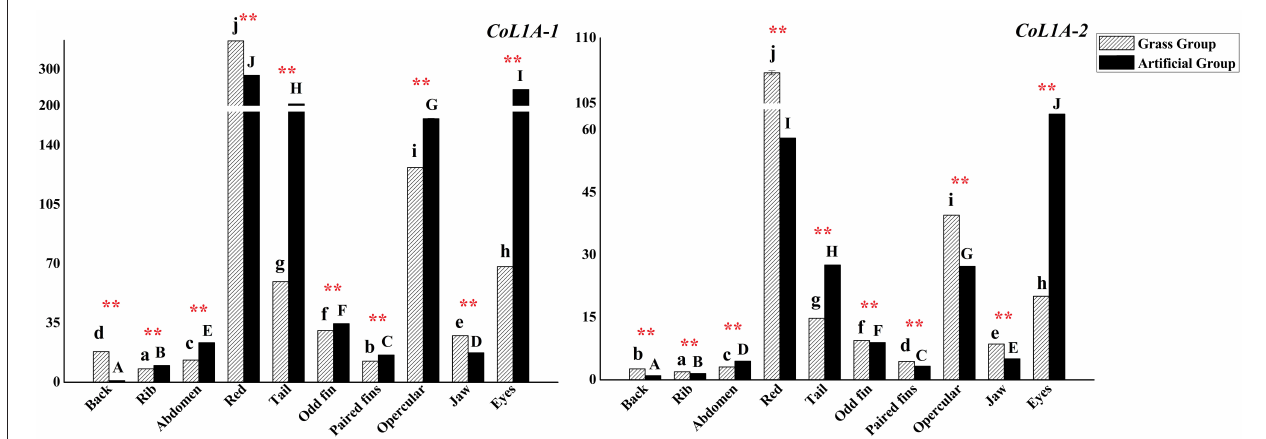
FIGURE 7 | The expression levels of C. idellus CoL1A - 1 and CoL1A - 2 in different muscle tissues . The expression levels of C. idellus CoL1A - 1 and CoL1A - 2 in back, rib, abdomen, red, tail, odd fin, paired fins, opercular, jaw, and eyes positions of the two culture models C. idellus . The expressions of genes in grass feed group represented in dense slash filling, which in artificial feed represented in black filling. The β -actin was used as an internal control to calibrate the cDNA template for all the samples. Vertical bars represent the mean SE. Different letters mean significantly different ( P < 0.05) in the same model, lowercase letters used in grass feed ± group, capital letters used in artificial feed group. Meanwhile, the star bars also indicate the significance between the two culture models in red color, **means greatly significant ( P <